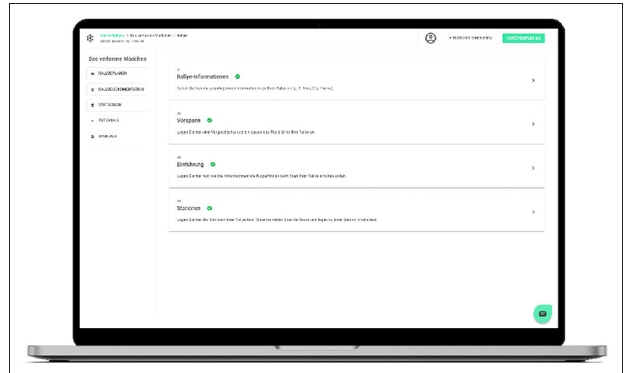
FIGURE 3 | Impressions of the Nebolus planning